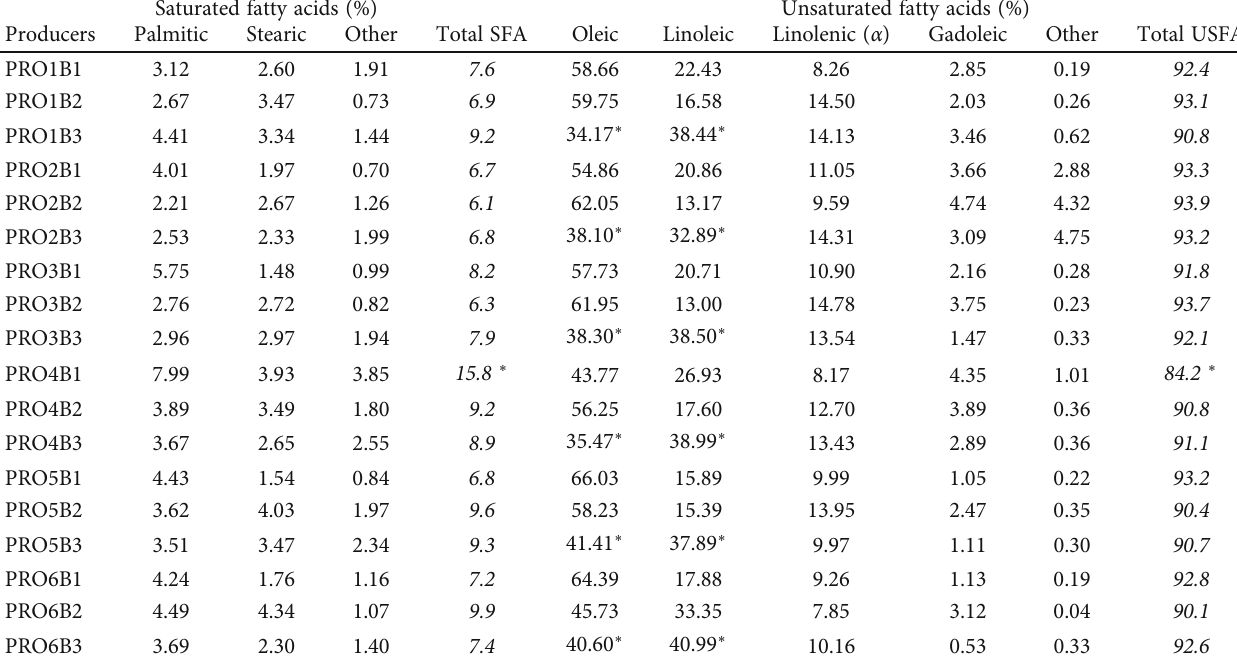
Figure 2: Green: linolenic acid (C18:3); purple: linoleic acid (C18:2); grey: palmitic acid (C16:0); red: oleic acid (C18:1); lime: stearic acid (C18:0); magenta: gadoleic acid (C20:0). Separating individual fatty acids in the rapeseed oil from producer 1, batch 1, via LCMS as outlined in Materials and Methods. Coloured peaks represent overlayed chromatograms of identi fi ed individual fatty acids separated and detected in PRO1B1. Table 2: Fatty acid pro fi le of rapeseed oil batches ( n = 3 ) outlining the primary compositional fatty acids. Saturated fatty acids